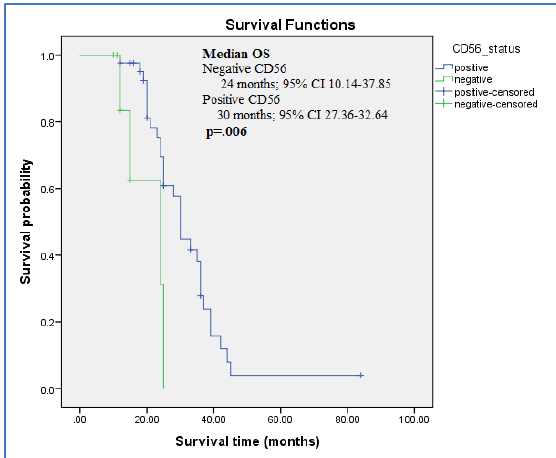
Figure 2: Kaplan Meier curves showing overall survival according to CD56 expression